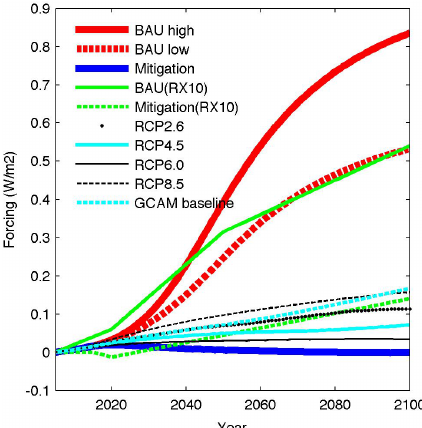
Fig. 1. HFC radiative forcing change (Wm − 2 ) since the year of Fig 1. HFC radiative forcing change (W/m2) since the year of 2005. Note we include both upper 423 2005. Note we include both upper (red solid line) and lower limits (red solid line) and lower limit (red dash line) of HFC growth under BAU scenarios. The 424 (red dash line) of HFC growth under BAU scenarios. The scenar- scenarios previously adopted in RX10 and from various other sources are shown for reference. 425 ios previously adopted in RX10 and from various other sources are shown for 426